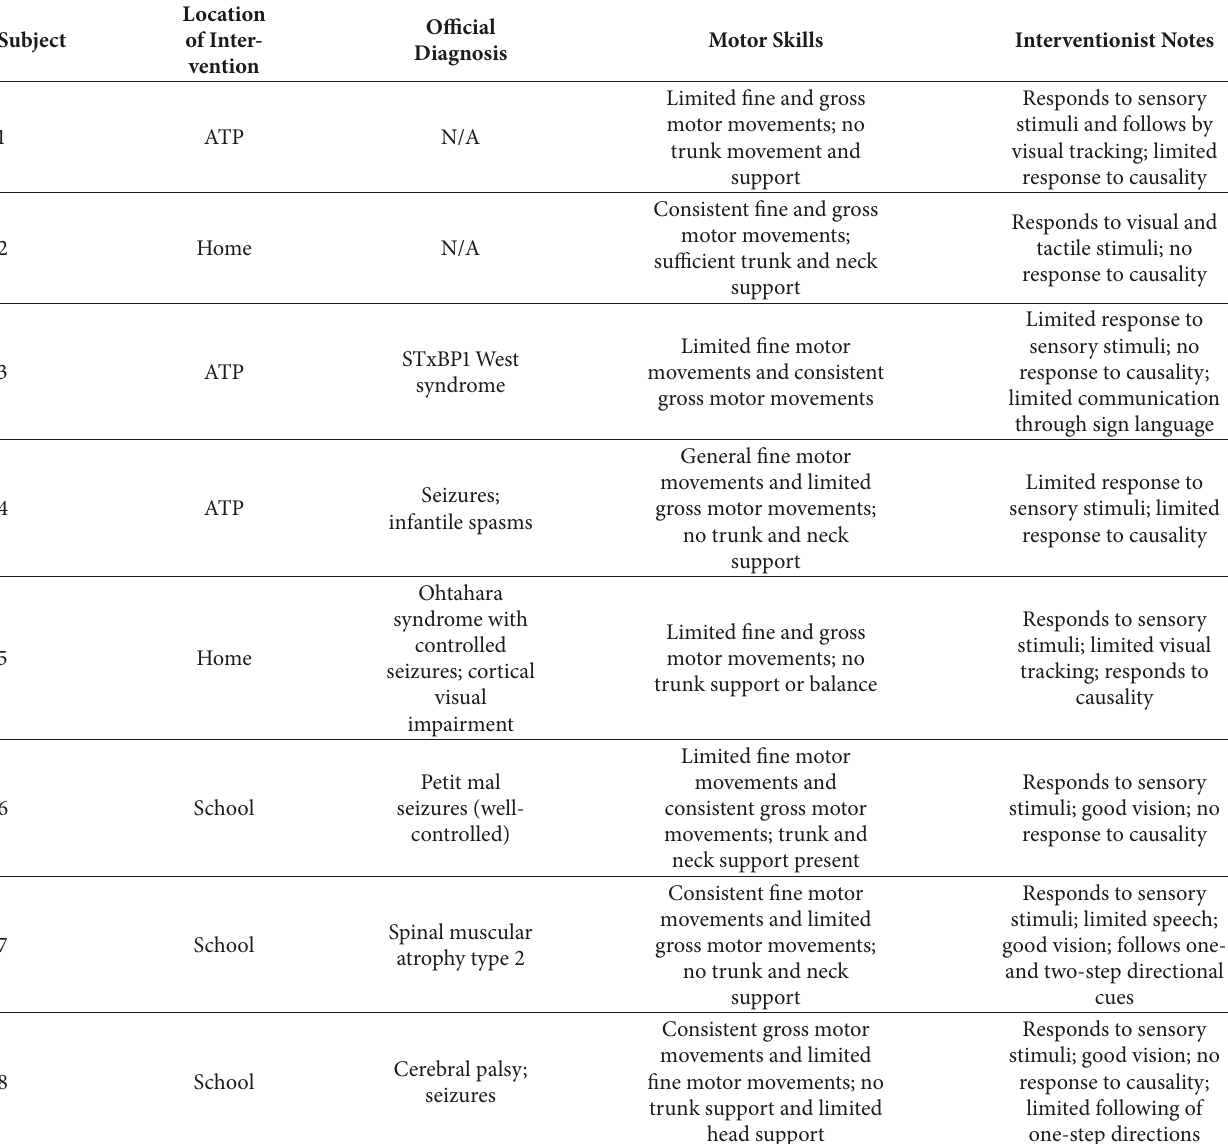
Table 4: Demographic table for study